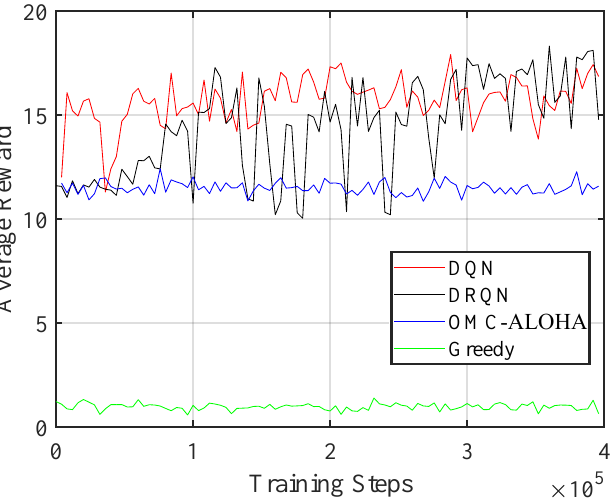
Figure 9. The average reward of the proposed method with different training steps (multiple SUs).